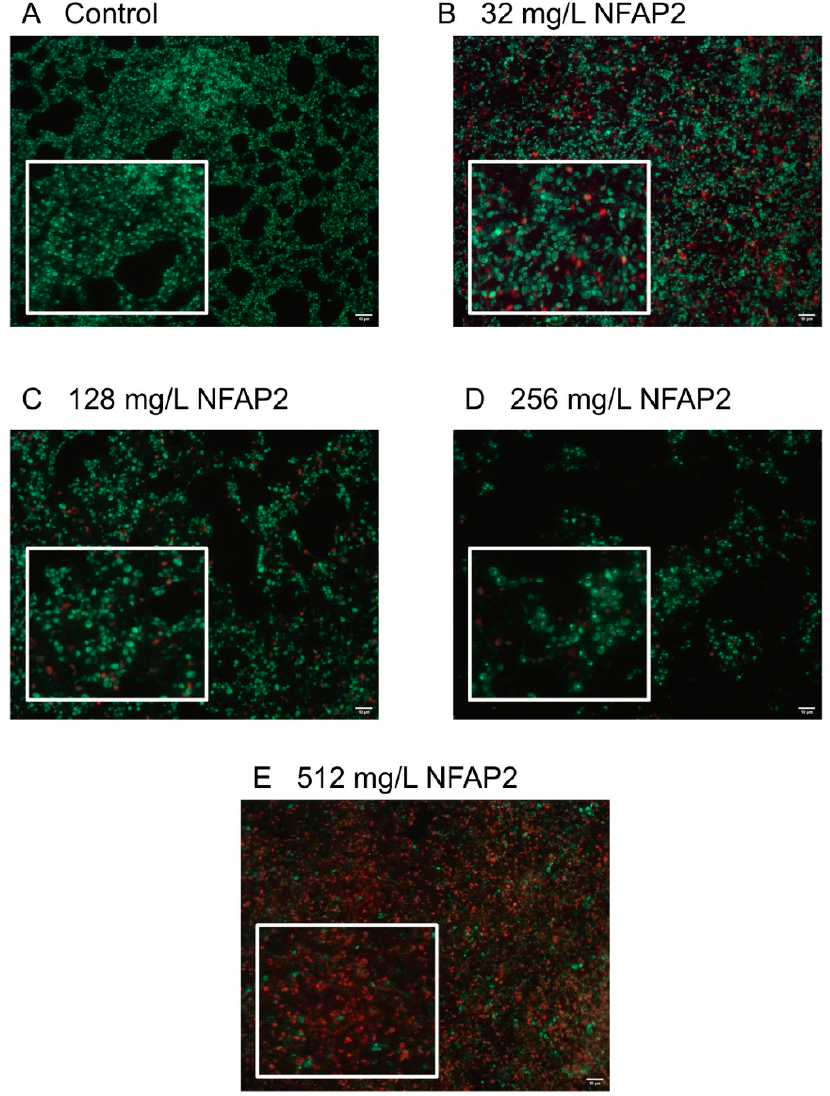
Figure 2. LIVE/DEAD fluorescence imaging of one representative C. auris isolate (isolate 10). Image ( A ) shows the untreated biofilm, while images ( B – E ) present the NFAP-exposed biofilms at 32 mg/L, 128 mg/L, 256 mg/L and 512 mg/L NFAP2 concentrations, respectively. Live cells (green) and nonviable cells (red) were stained with Syto9 and propidium iodide, respectively. All images show typical fields of view. Scale bars represent 10 μ m.